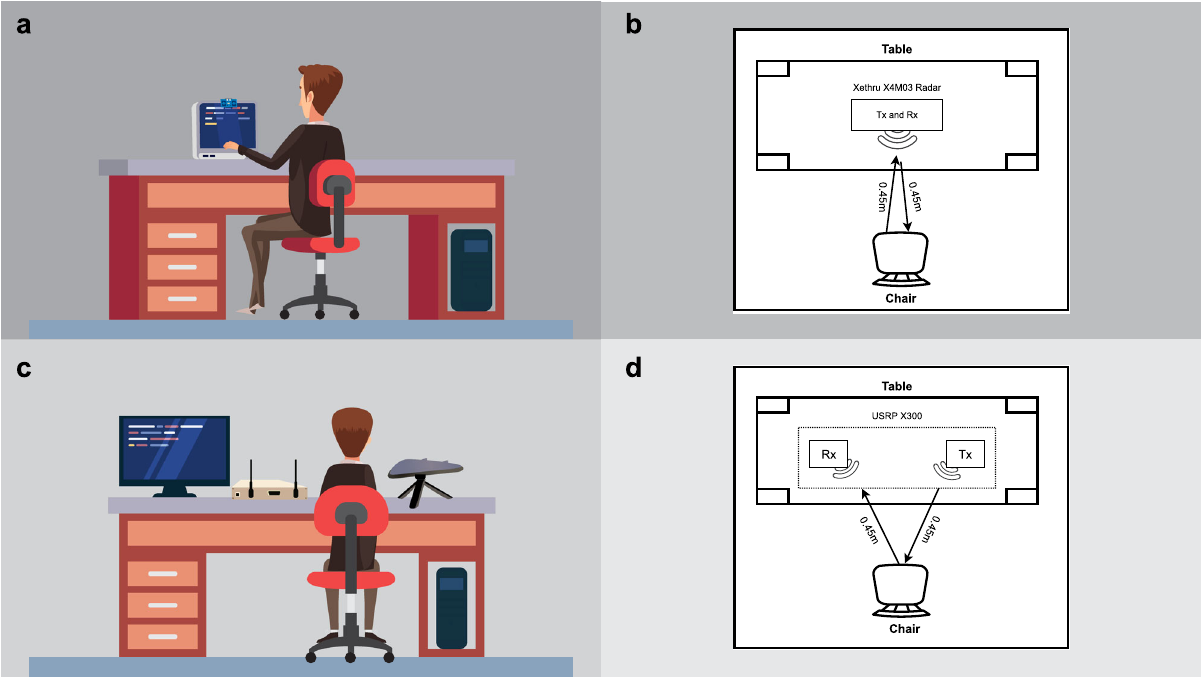
Fig. 3 | Experimental setup of the data collection through radar and Wi-Fi. a FrontviewofthedatacollectionsetupusingXethruUWBradar. b Topviewofthe